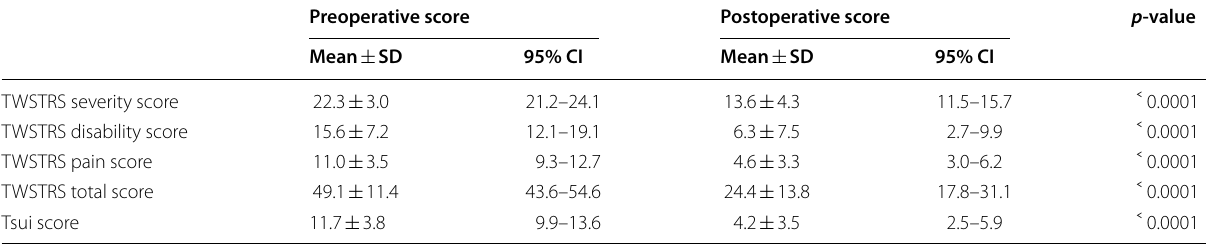
Table 7 Comparison of the preoperative and 6 months postoperative results according to TWSTRS severity, disability, pain, and total score, and Tsui